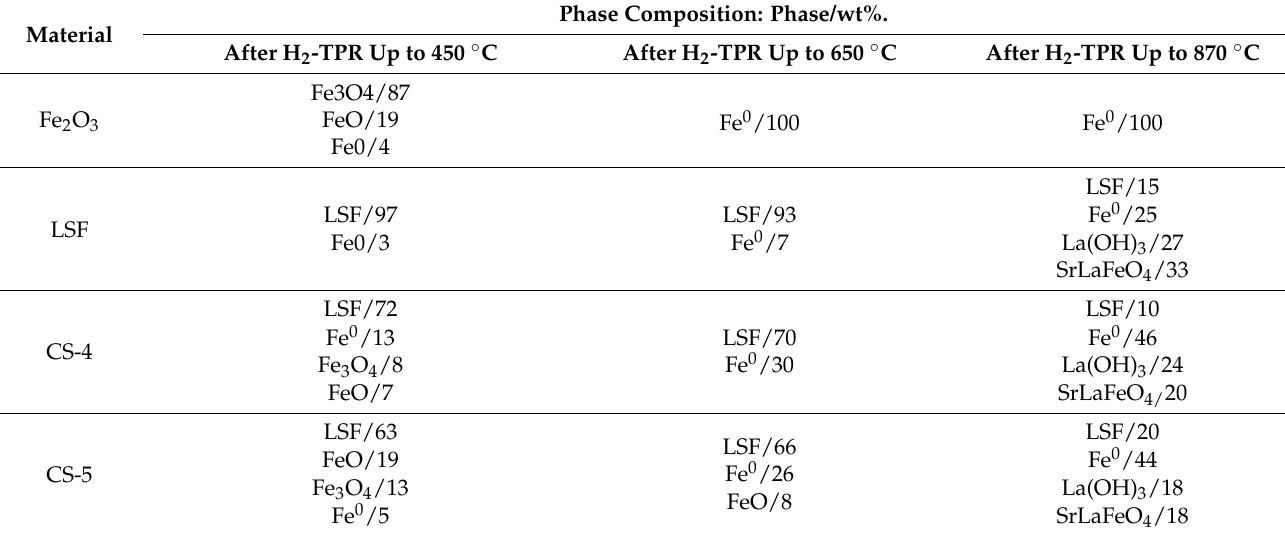
Table 5. Phase composition of Fe 2 O 3 , LSF, CS-4 and CS-5 after H 2 -TPR tests. Phase Composition: Material